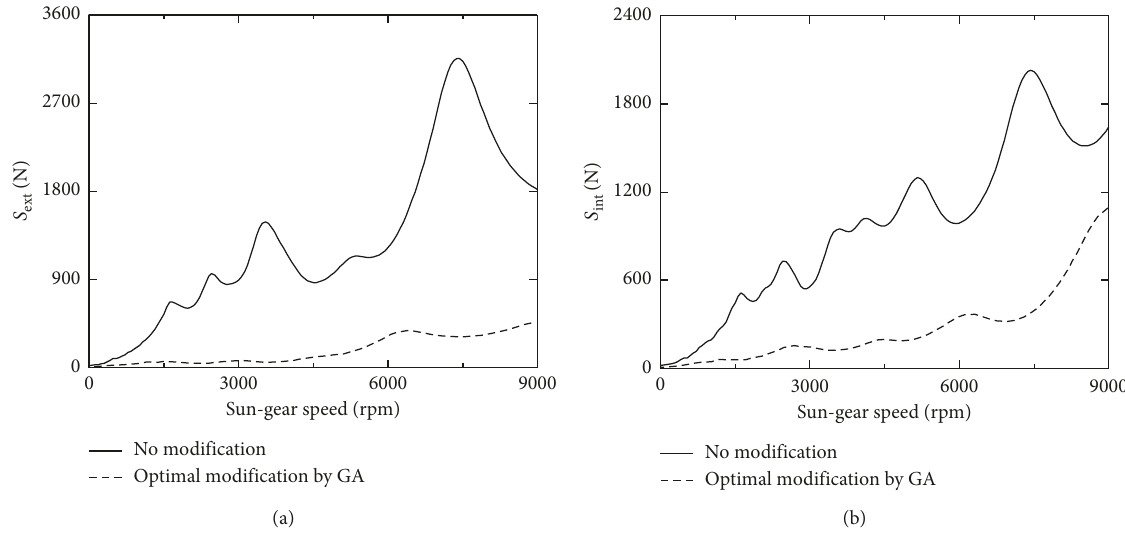
Figure 20: Dynamic tooth loads for (a) external meshes and (b) internal meshes of no modification (black line) and optimal modification by the GA (dash